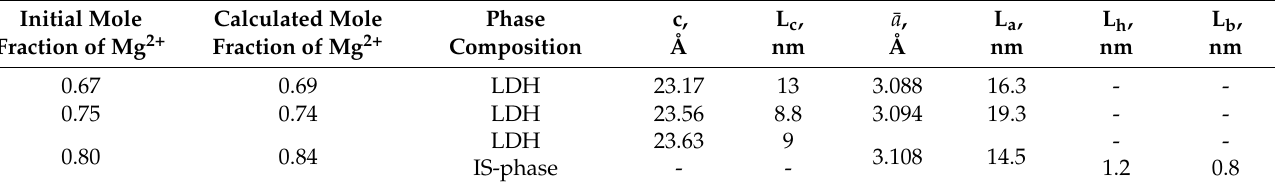
Table 3. Microstructural characteristics for MgGa-OH samples after hydration of oxides.